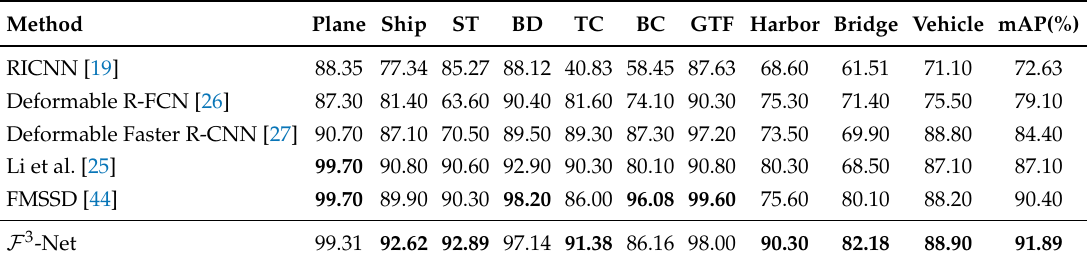
Figure 7. F-measure curves of different objects on NWPU VHR-10 dataset. Table 4. Result comparison of baselines and F 3 -Net for HBB task on NWPU VHR-10 dataset.